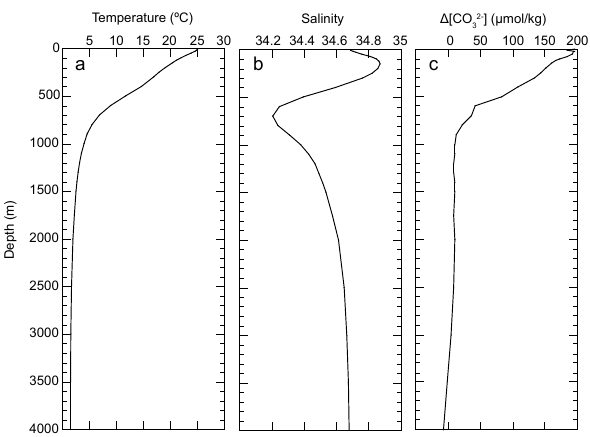
Figure 3. (a) Annual temperature and (b) salinity profile at World Ocean Atlas Station #664355 (Locarnini et al., 2013; Zweng et al., 2013) and (c) (cid:49) [CO 2 − ] at Global Ocean Data Analysis Project 3 (GLODAP) station #28582 (Key et al.,